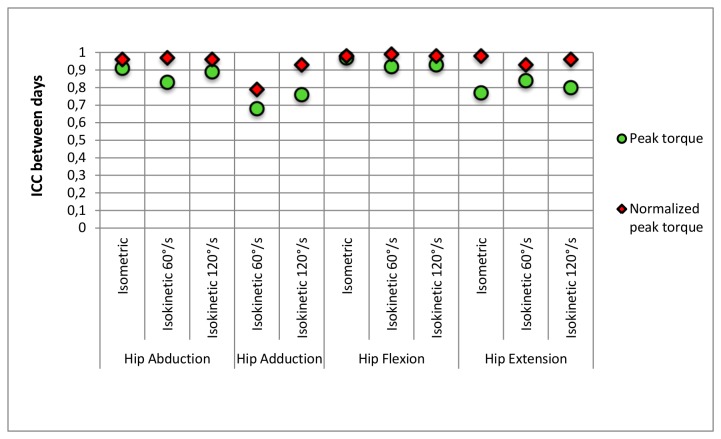
Reliability of isokinetic and isometric tests.